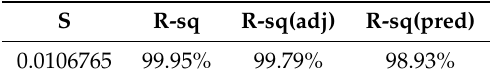
Table 19. Model summary.